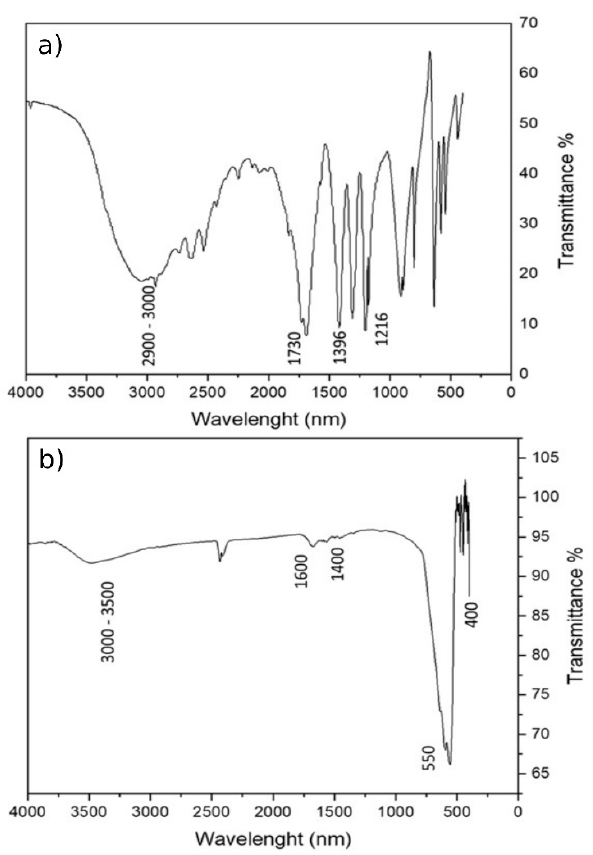
Figure 3. FTIR analysis ( a ) spectrum of succinic acid, and ( b ) MA coated with succinic acid . The effect of the concentration of the succinic acid on the size distribution of the coated nanoparticle aggregates was evaluated. Figure 4a,b report the results of the analy- sis of the aggregates obtained with two different percentages w/w of succinic acid com- pared to the weight of magnetite core. Using 10% w/w of succinic acid results in aggregates with an average diameter of 30 μ m (Figure 4a). Decreasing the coating to a percentage of 5% w/w leads to aggregates with a dimension of 50 μ m (Figure 4b) due to the effect of the succinic acid acting as a stabilizer. The coating is expected to cover the surface of the na- noparticles, preventing aggregation. Succinic acid guarantees a negative charge on the surface of nanoparticles and this negative charge acts as a repulsive force, preventing the agglomeration [25,26].